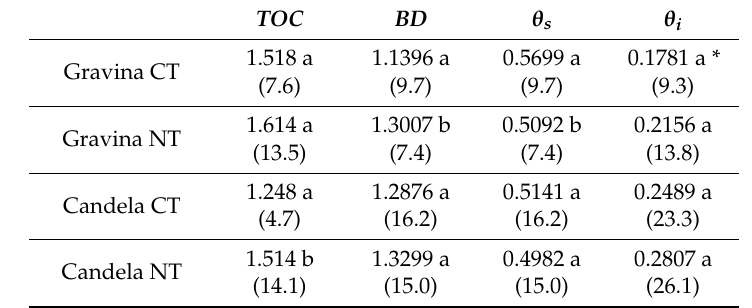
Table 3. Mean and associated coefficient of variation (CV, in parenthesis) of initial and saturated volumetric soil water content, θ i and θ s (cm 3 /cm 3 ), bulk density, BD (g/cm 3 ), and total organic carbon, TOC